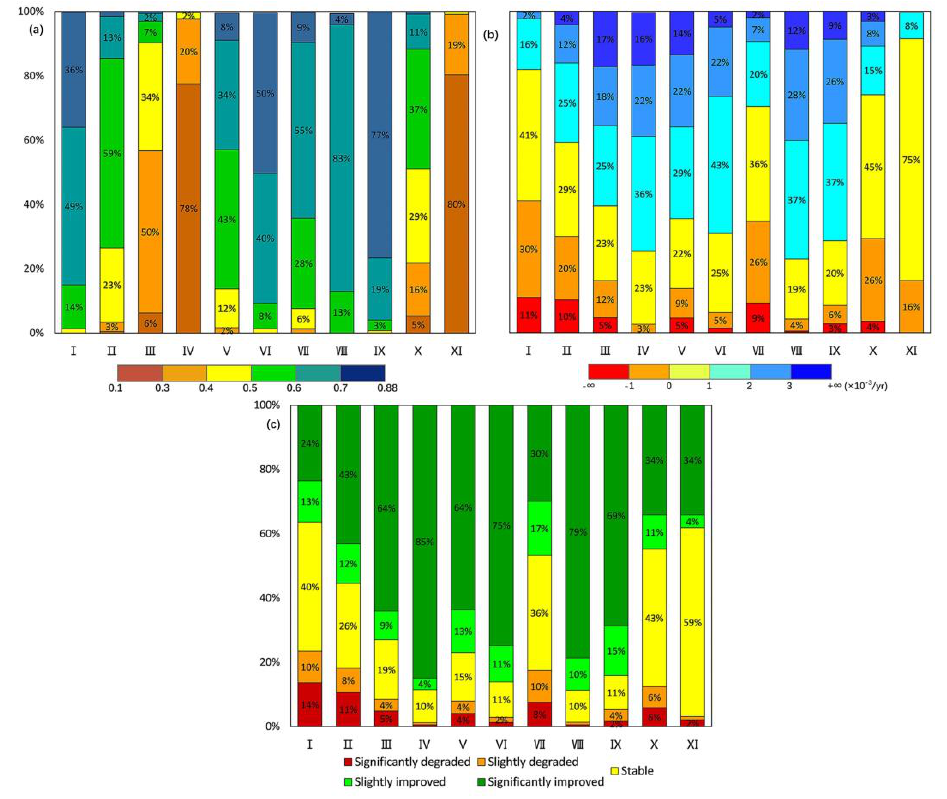
Figure 6. The percentage distribution of ( a ) mean annual GS-NDVI, ( b ) trends, and ( c ) change degrees in 11 sub-regions during 1982−2015.